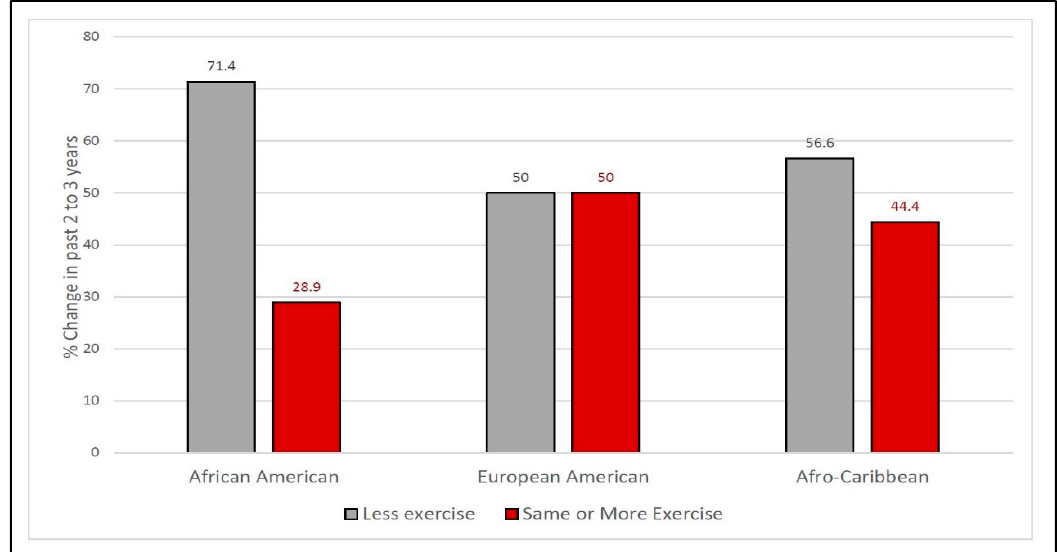
Figure 1. Percent reporting declined, sustained, or increased activity in the last 2–3 years by ethnic group.